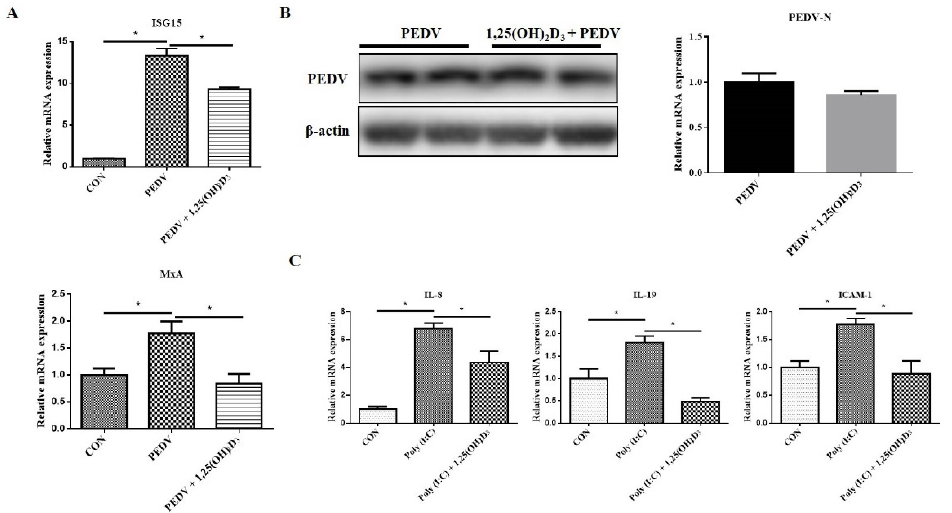
Figure 7. Effects of 1,25(OH) 2 D 3 on PEDV replication. Sub-confluent cells were incubated with 1,25(OH) 2 D 3 (20 nM) for 24 h, after which the cells were infected with PEDV. After 1 h of absorption, the cells were washed with PBS and then cultured with 1,25(OH) 2 D 3 (20 nM) for another 24 h. Then, the cells were collected for RT-qPCR analysis ( A ) and PEDV-N mRNA and protein determination ( B ). IPEC-J2 cells were incubated with 1,25(OH) 2 D 3 (20 nM) for 24 h, and then the cells were transfected with poly(I:C) by Lipofectamine 3000 reagent (Invitrogen) for an additional 24 h. Finally, the cells were collected for RT-qPCR analysis ( C ). * p < 0.05.